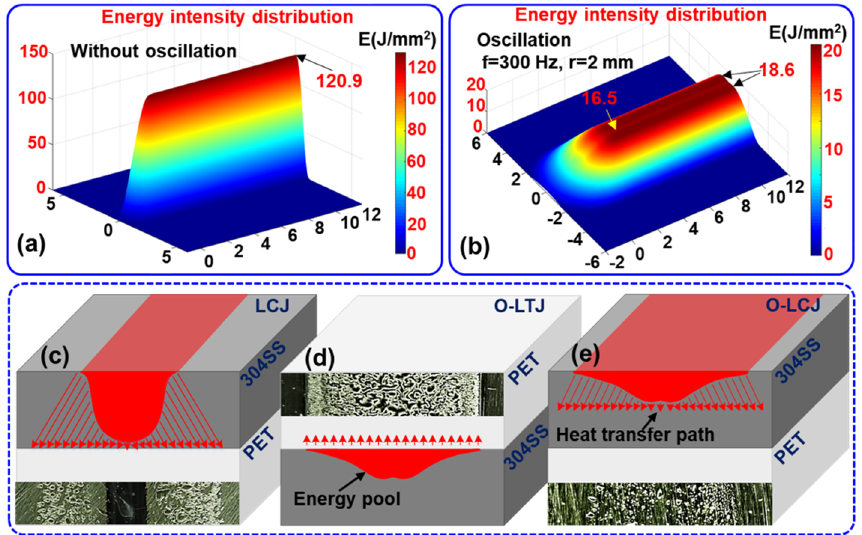
Figure 9. The energy intensity distribution and heat transfer model of joints: ( a ) energy intensity distribution without oscillation, ( b ) energy intensity distribution with oscillation, ( c ) heat transfer model of LCJ, ( d ) heat transfer model of O-LTJ, ( e ) heat transfer model of O-LCJ.